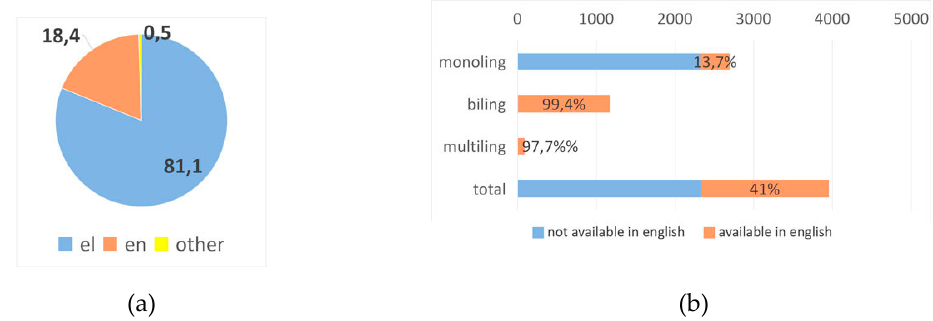
Figure A12. Visualization of the results for domain gr. ( a ) Primary languages pie chart and ( b ) English